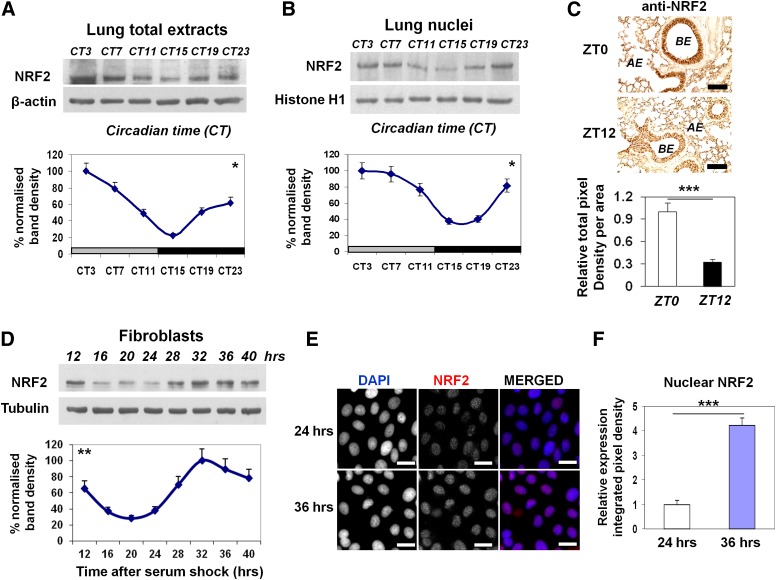
Circadian expression of NRF2 protein in mouse lungs and fibroblast cells. (A,B) Representative Western blots of rhythmic NRF2 levels in total lung lysates and nuclear extracts from wild-type (WT) mice kept in DD. NRF2 densitometry (mean ± SEM) was normalized to β-actin or histone H1, and the highest expression set as 100%. (Gray bar) Subjective day; (black bar) subjective night. One-way ANOVA for the effect of time, (*) P < 0.05. (C) Representative micrographs of histological lung sections showing temporal NRF2 immunoreactivity at ZT0 versus ZT12. Brown NRF2 staining was localized mainly to bronchial epithelium (BE) and alveolar epithelium (AE). Mean ± SEM; (***) P < 0.001, t-test. Bar, 100 μM. (D) Representative Western blots of temporal NRF2 levels in total lysates of Rat1 fibroblasts following serum shock. NRF2 densitometry (mean ± SEM) was normalized to tubulin. Harvest of cells started at 12 h after serum shock to exclude the initial gene induction. (**) P < 0.01, one-way ANOVA for the effect of time. (E, F) Representative immunofluorescent micrographs and quantification of endogenous NRF2 in Rat1 cells at 24 h or 36 h after serum shock. Nuclei were counterstained with DAPI. Bar, 50 μM. (***) P < 0.001, t-test.